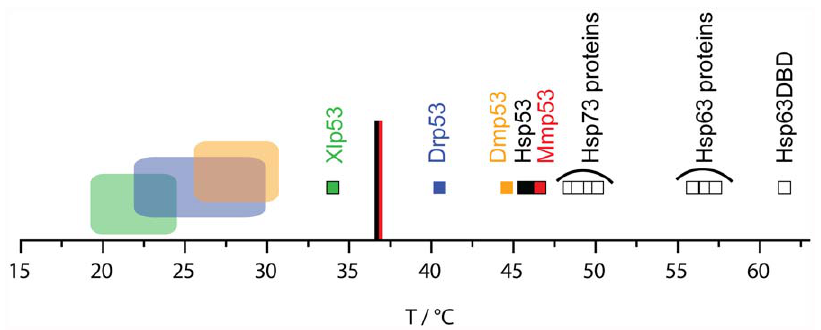
Figure 5. Overview of protein melting temperatures (small squares) within the p53 family. p53 orthologs (filled squares; Hsp53 in black, Mmp53 in red, Dmp53 in orange, Drp53 in blue and Xlp53 in green) and p53 paralogs (hollow squares) are shown. In corresponding colours body temperatures of homeothermic organisms are indicated as lines and optimal development conditions of poikilothermic organisms are illustrated as large